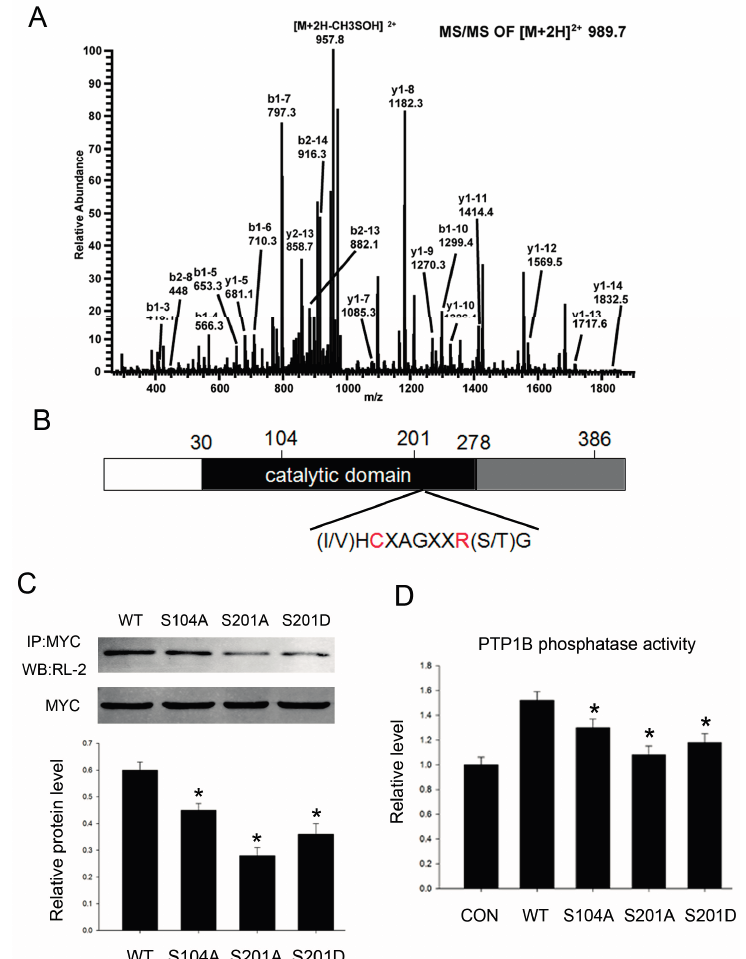
Figure 3. PTP1B is O -GlcNAc modified at three sites. ( A ) ETD MS/MS site mapping of the human PTP1B O -GlcNAc modification sites; ( B ) Schematic diagram shows full-length PTP1B domain structure and O -GlcNAc sites (Ser104, Ser201, and Ser386); C (Cys215) and A (Arg221), two residues which are critical for the catalytic activity of PTP1B; ( C ) We constructed site-directed mutants (Ser104 mutated to alanine, Ser201 mutated to alanine and aspartic acid), then HepG2 cells were transfected with pcDNA3.1/myc-His ( − ) vectors containing the indicated site mutations for 24 h before treating with 0.2 mM palmitate acid for 18 h. Then cells were immunoprecipitated with an anti-myc antibody followed by immunoblotting with an anti- O -GlcNAc antibody (RL-2); ( D ) PTP1B phosphatase activity was analyzed by protein phosphatase assay kit according to the manufacturer’s instruction. Data show mean ± SEM of three independent experiments. ( n = 3, * p < 0.05, significantly different from respective